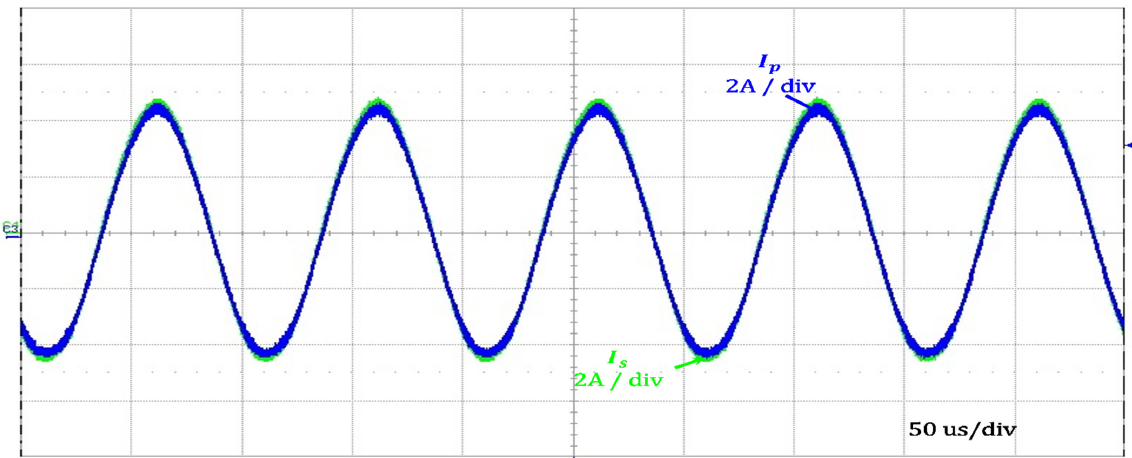
Figure 8. Primary winding and secondary winding current results of the filament in the insulating transformer. (Note: I p : 1st wind current, I s : 2nd wind current).